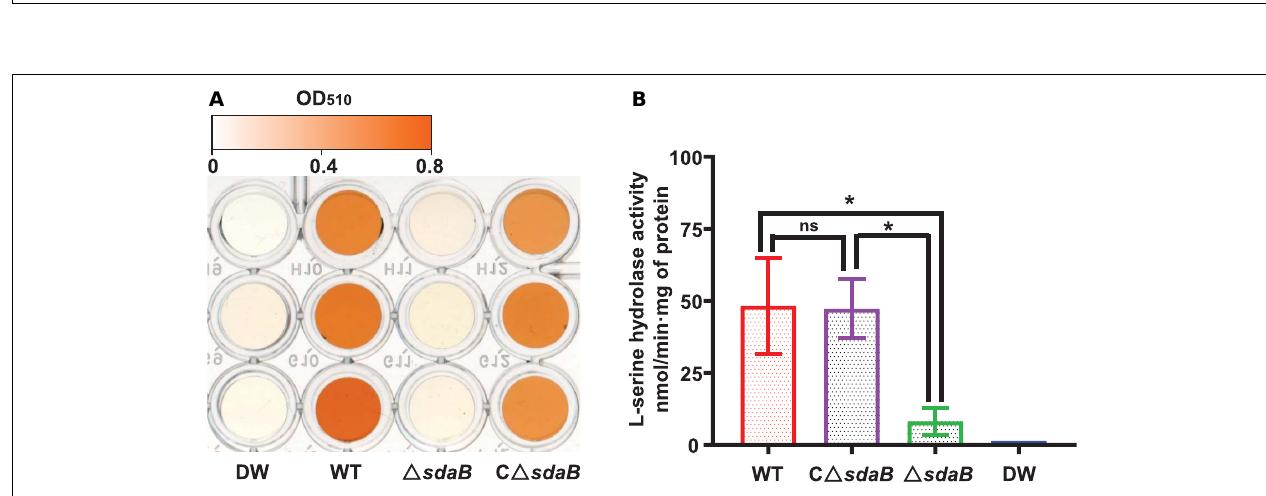
FIGURE 5 | L -serine hydrolase activity of E. ludwigii AA4 and its sdaB gene knock-out mutant. (A) Colorimetrical quantification of pyruvate generated in a L -serine hydrolase activity assay. The color shown in each well of the microplate corresponds to the pyruvate concentration measured by a spectrophotometer at 520 nm. The values of optical density (OD) range from 0 (white) to 0.8 (orange). (B) Comparison of L -serine hydrolase activities of wild-type E. ludwigii AA4, its sdaB gene knock-out mutant, and AA4 (cid:49) sdaB complemented with a wild-type sdaB gene. DW, distilled water; WT, E. ludwigii AA4 wild-type strain; (cid:49) sdaB , AA4 sdaB gene knock-out mutant; C (cid:49) sdaB , AA4 (cid:49) sdaB complemented with a wild-type sdaB gene. The asterisks indicate that differences among the means represented by the columns are statistically significant (* P < 0.0001). Two-tailed t -test (GrapPad Prism 8) was used for the analysis.